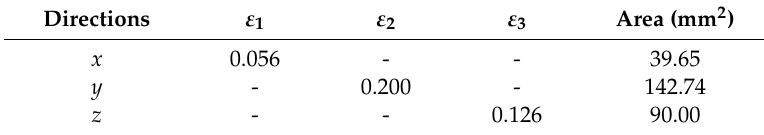
Table 5. Strain under simple tension in AB/F-DW corrugated paperboard.